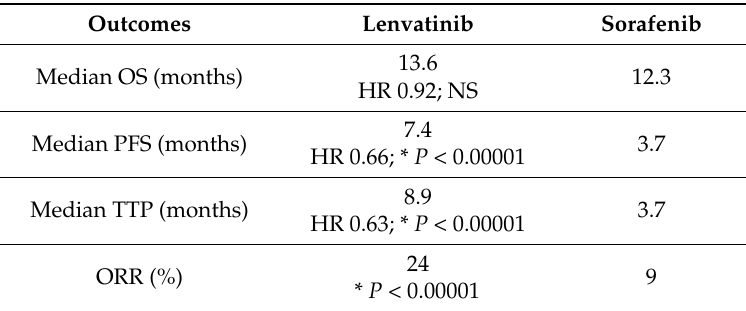
Table 7. Results of a phase III clinical trial to investigate lenvatinib vs sorafenib in unresectable hepatocellular